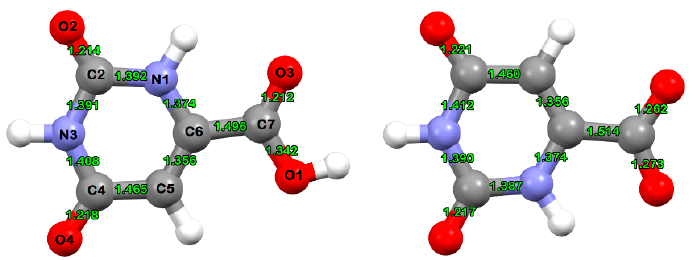
Figure 1. B3LYP/cc-pVDZ(SDD)-optimized molecular structures of the orotic acid ligand ( left ) and Figure 1. B3LYP/cc ‐ pVDZ(SDD) ‐ optimized molecular structures of the orotic acid ligand ( left ) and the orotic acid anion ( right ). the orotic acid anion ( right